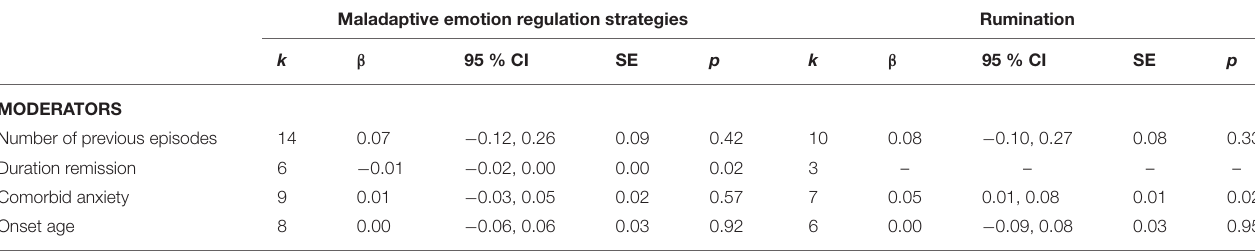
TABLE 4 | Meta-regression with studies including participants with remitted